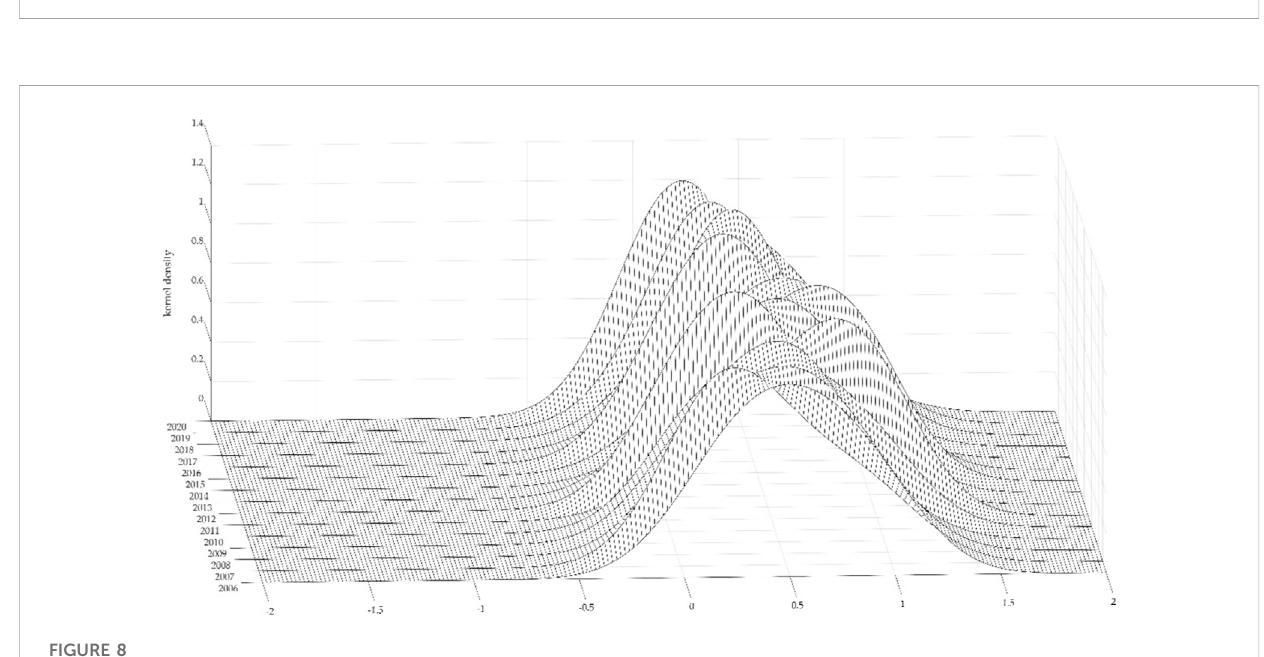
FIGURE 8 Dynamic evolution at the central